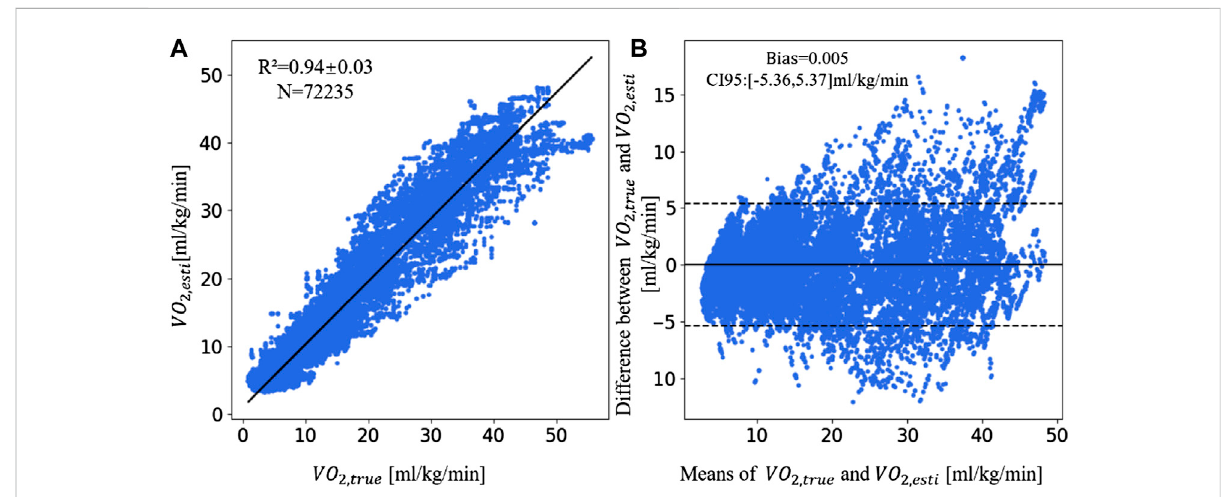
FIGURE 3 The linear correlation plot and consistency plot of VO 2 , esti and VO 2 , true . (A) The scatter plot of VO 2 , esti and VO 2 , true . (B) The Bland-Altman plot of VO VO VO 2 , esti and 2 , true . (Abbreviations: 2 , esti : the estimated VO 2 by XGBoost model,